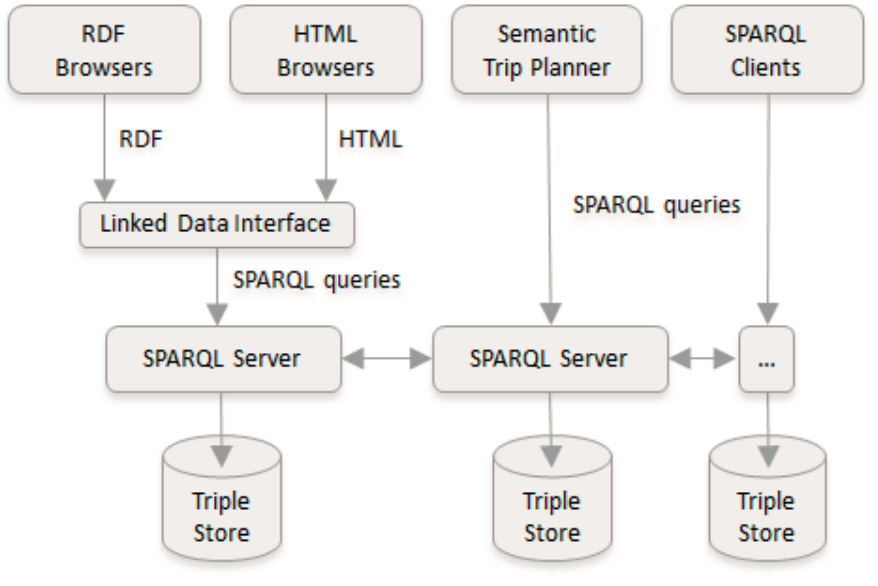
Figure 7. System Architecture for Multimodal Transport Information